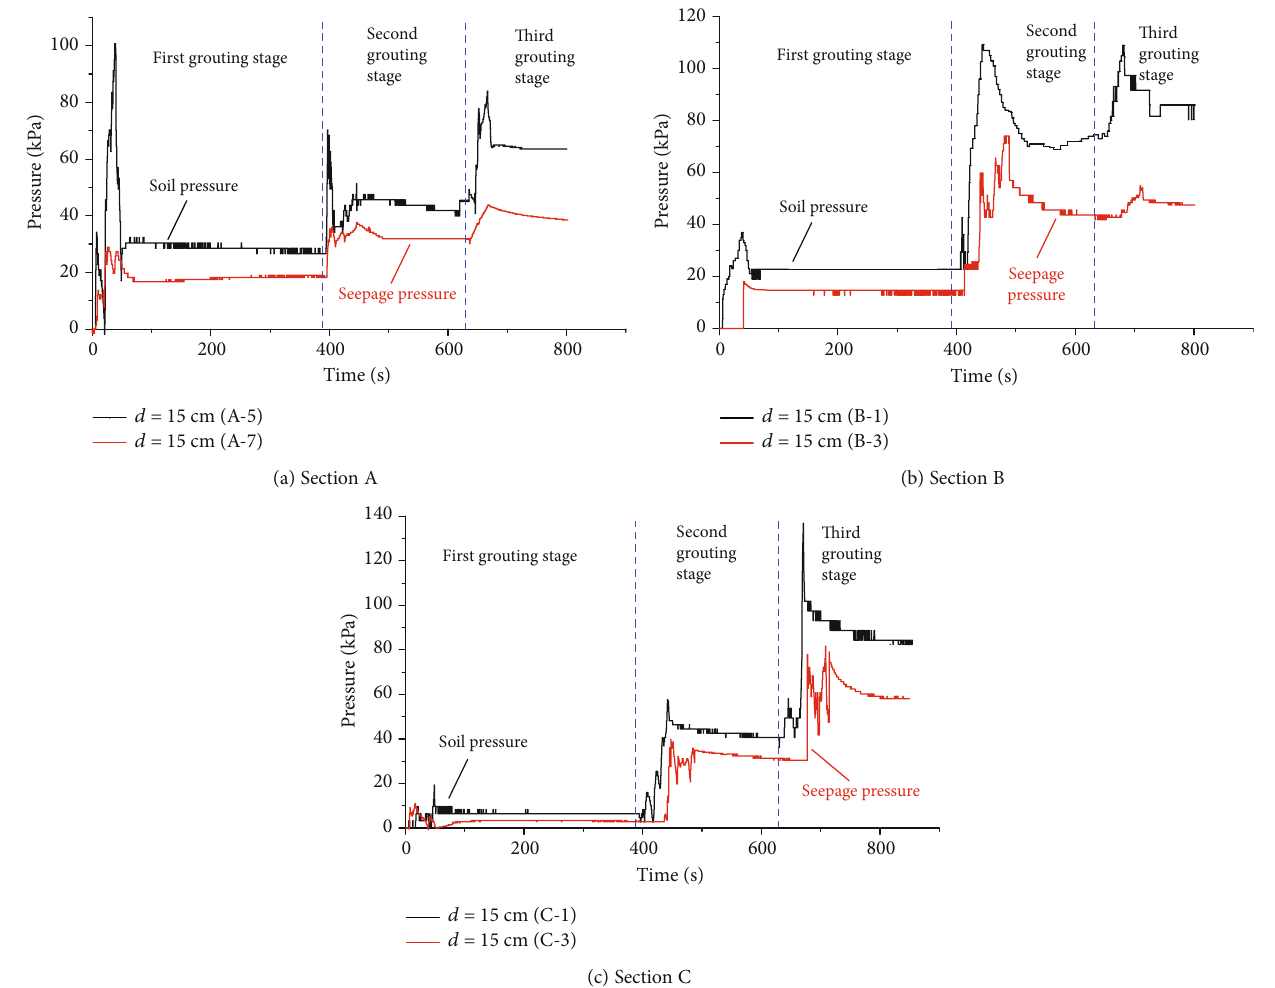
Figure 13: Variation of seepage pressure with time in three grouting